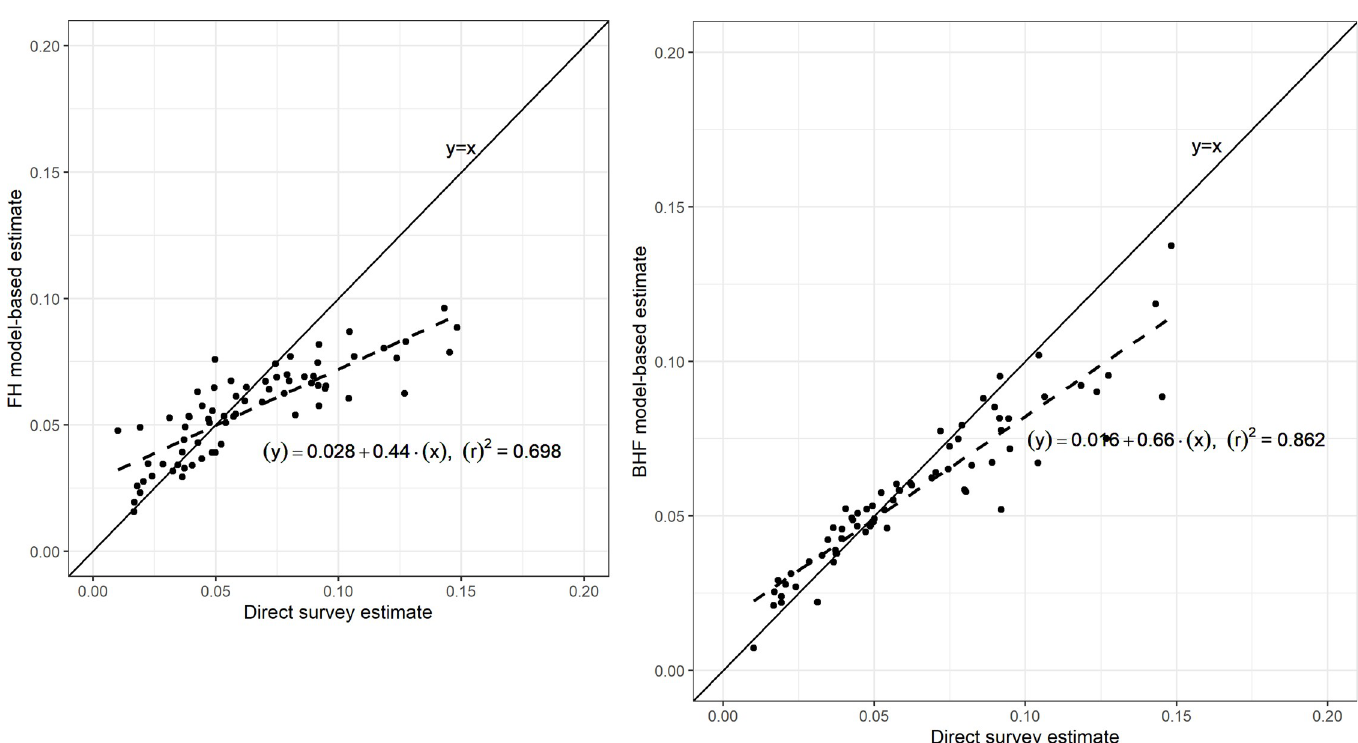
Fig 2. Correlation of model and direct survey estimates of HIV prevalence in Uganda. Regression and scatter plot of (a) area-level model estimates compared to direct survey estimates and (b) unit-level model estimates compared to direct survey estimates.